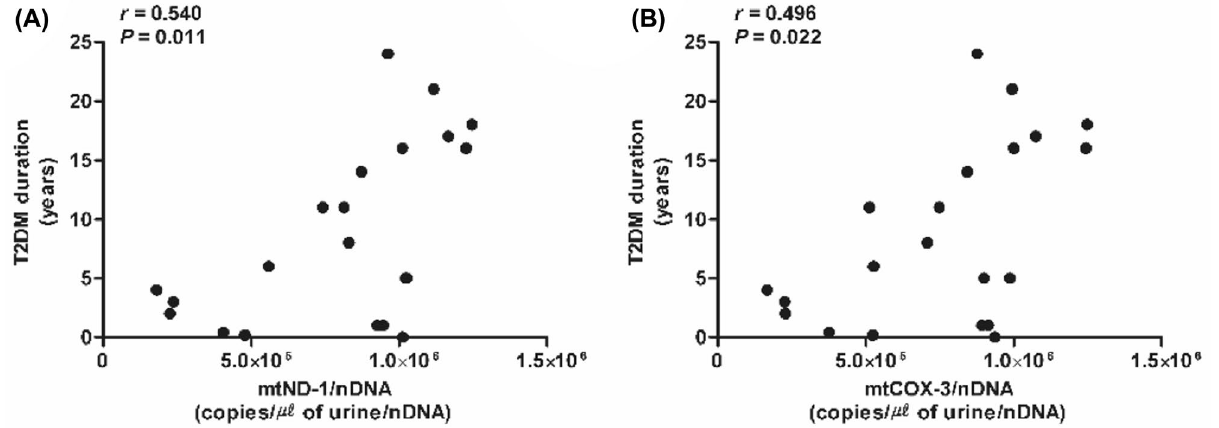
Figure 2. Correlation between urinary mtDNA copy numbers and T2DM duration ( n = 21). ( A ) urinary mtND-1, and ( B ) urinary mtCOX-3. Statistical analysis was performed using SPSS (version 25.0, SPSS, Chicago, IL, USA, www. ibm. com/ analy tics/ spss- stati stics- softw are) and figure was plotted using GraphPad Prism (version 5.03, GraphPad Software, San Diego, CA, USA, www. graph pad. com). mtCOX-3 cytochrome-c